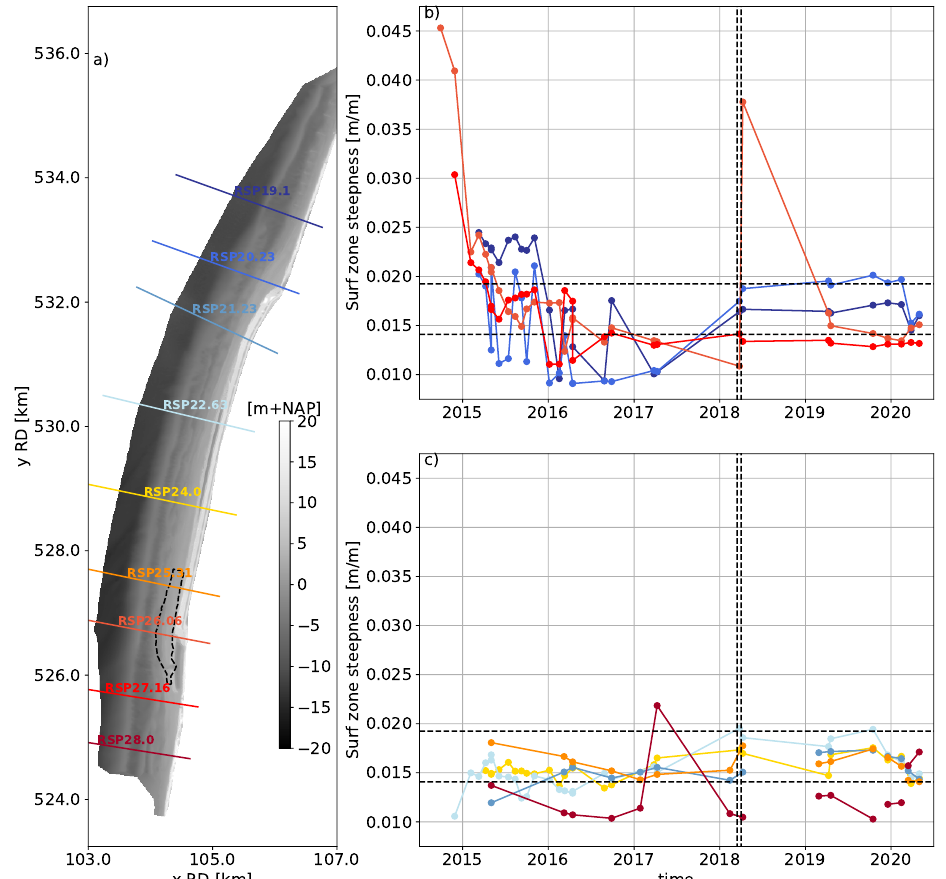
Figure 10. Surf and intertidal zone slope ( − 4.8/1 m + NAP) adaptation in time. ( a ) Location of transects and 2018 nourishment; ( b ) slope at initially steeper profiles at km 19.1, 20.23, 26.06, and 27.16; ( c ) slope at initially smoother profiles at km 21.23, 22.63, 24.0, 25.31, and 28.0. The black dotted horizontal lines indicate the µ ± σ profile steepness of the adjacent coast. The black dotted vertical lines indicate the period of additional beach nourishment between km 25 and